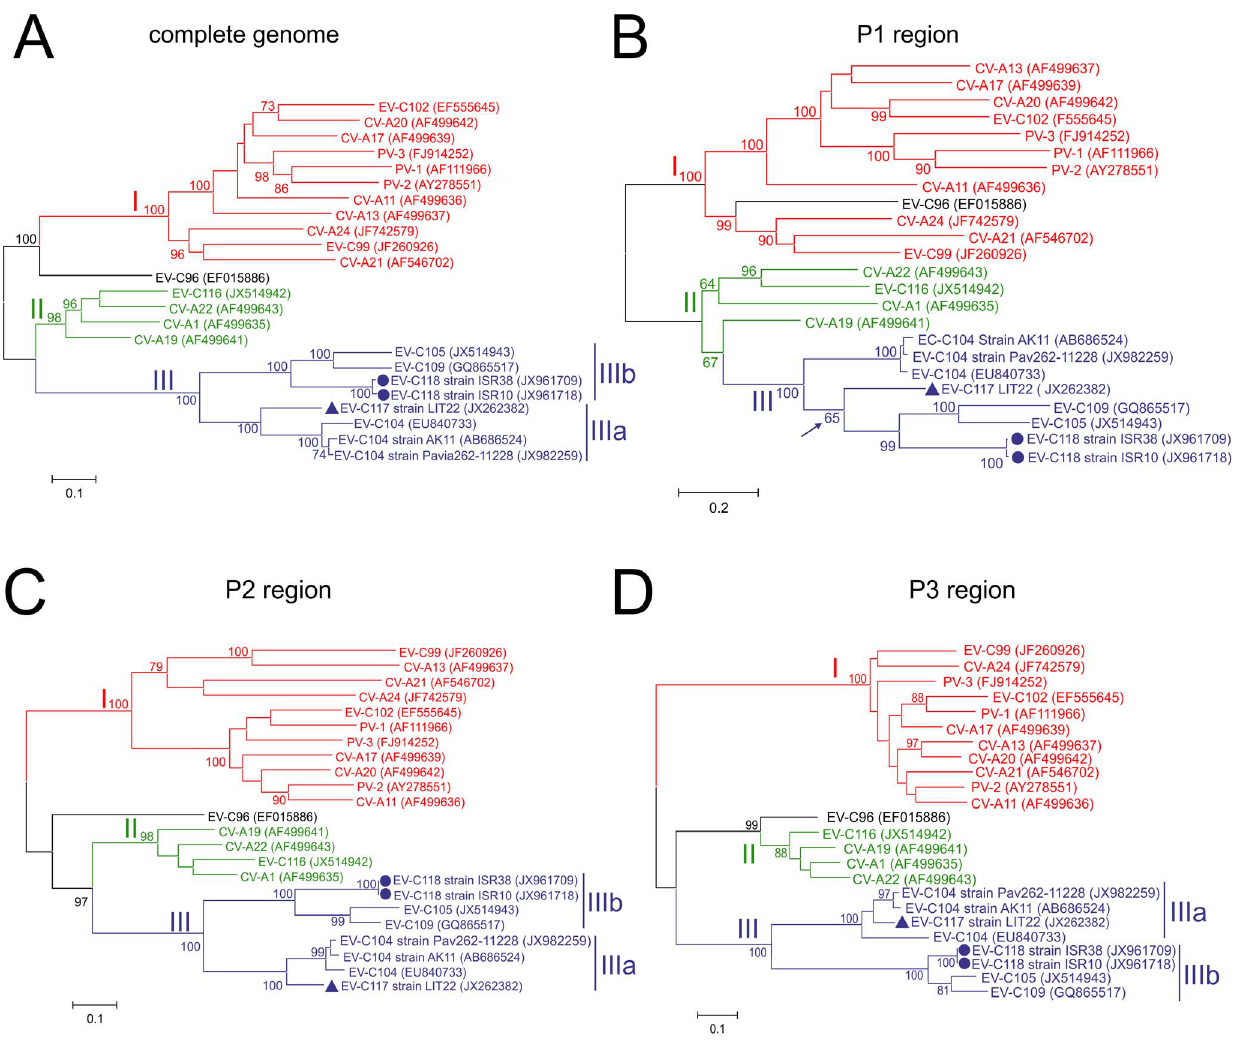
Figure 4. Maximum likelihood trees based on EV-C117, EV-C118 and HEV-C virus nucleotide sequences. Separate tress were constructed for the complete genome (A), and the P1 (B), P2 (C), and P3 regions (D).